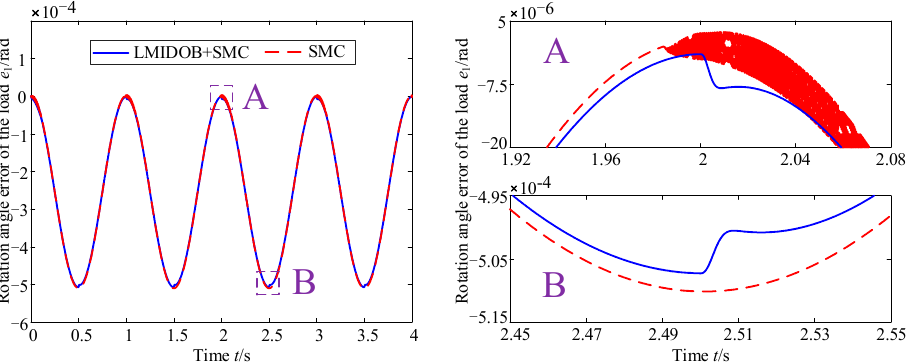
Figure 7. Position tracking performance of control strategy at constant stiffness condition.